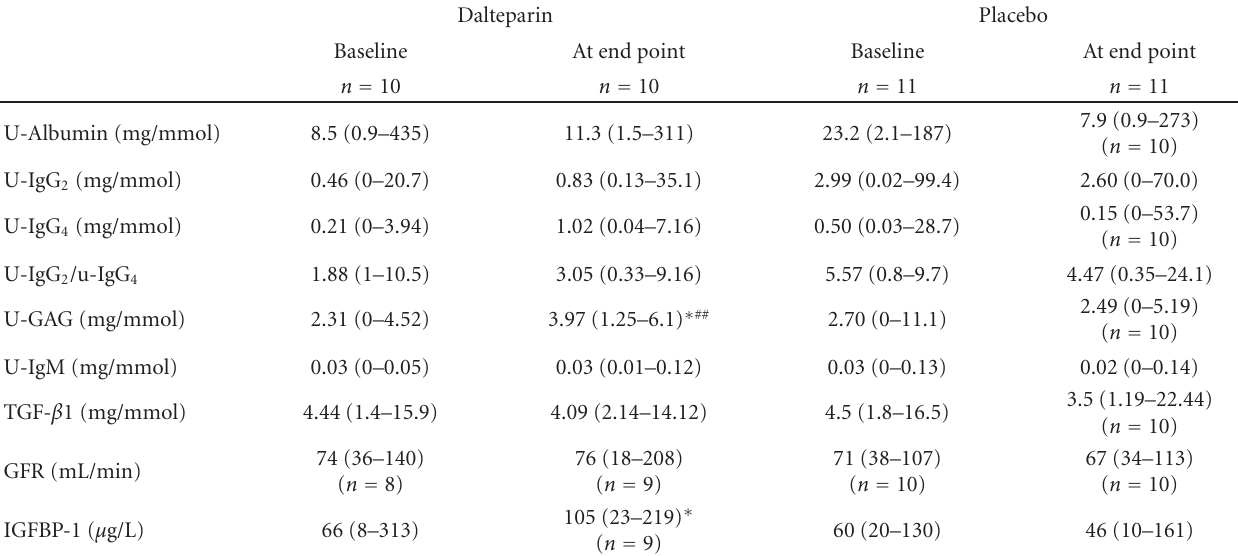
Table 4: Diabetic patients with micro- or macroalbuminuria: e ff ects of treatment on urinary